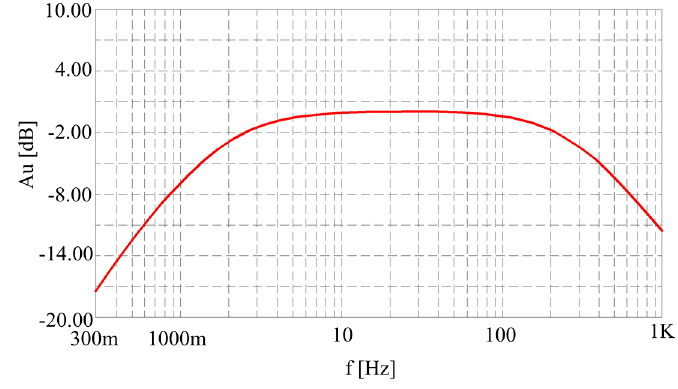
Figure 2. Frequency range of the ViGeo2 sensor.